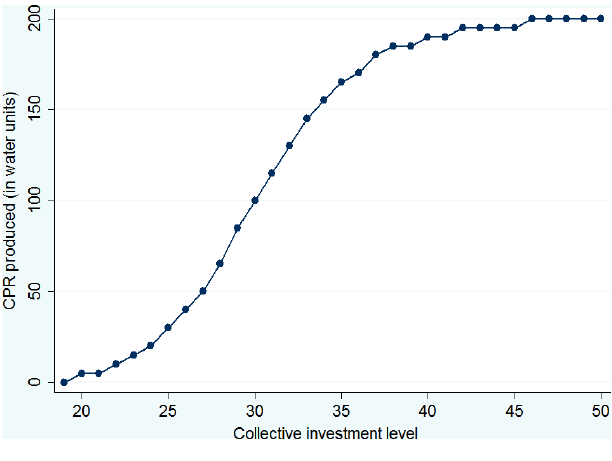
Fig. 2. Common-pool resource production function. Based on Janssen et al. (2011 b